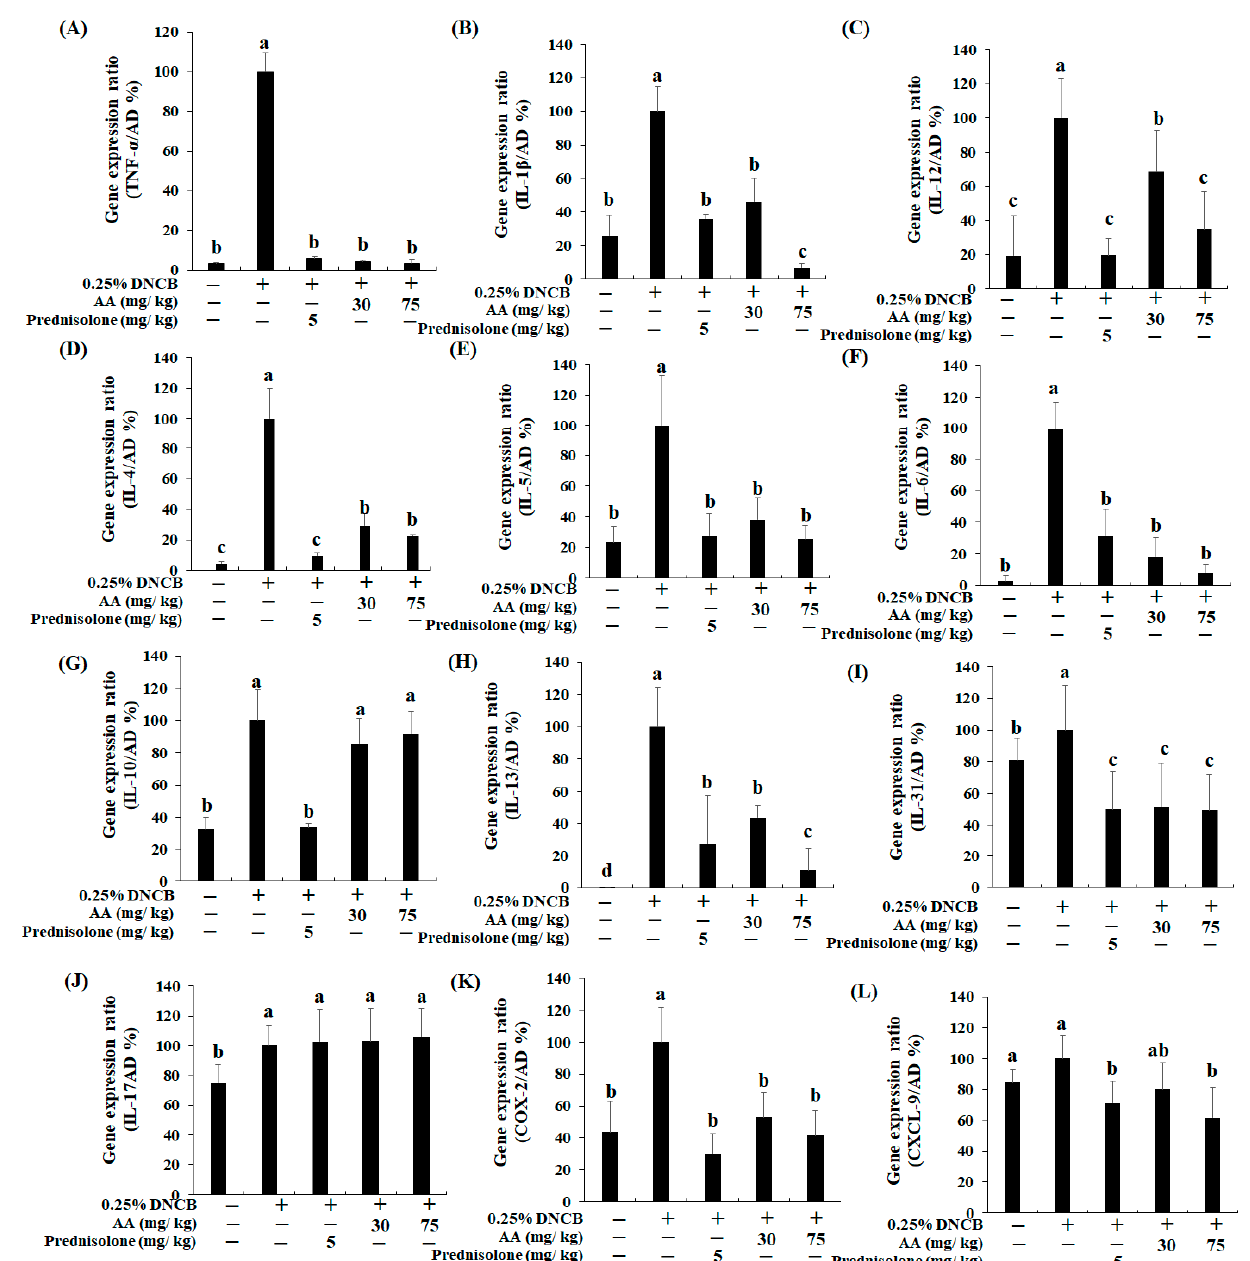
Figure 6. Asiatic acid (AA) effects on atopic dermatitis (AD)-related cytokine expression level in the dorsal skin of 2,4- dinitrochlorobenzene (DNCB)-induced AD mice. ( A ) Tumor necrosis factor (TNF)- α ; ( B ) interleukin (IL)-1 β ; ( C ) IL-12; ( D ) IL-4; ( E ) IL-5; ( F ) IL-6; ( G ) IL-10; ( H ) IL-13; ( I ) IL-31; ( J ) IL-17; ( K ) cyclooxygenase (COX)-2; and ( L ) chemokine ligand (CXCL)-9. As per Duncan’s multiple range test ( p < 0.05), the significant values are represented by different letters. The results are expressed as the mean ± standard deviation ( n = 7 per group).